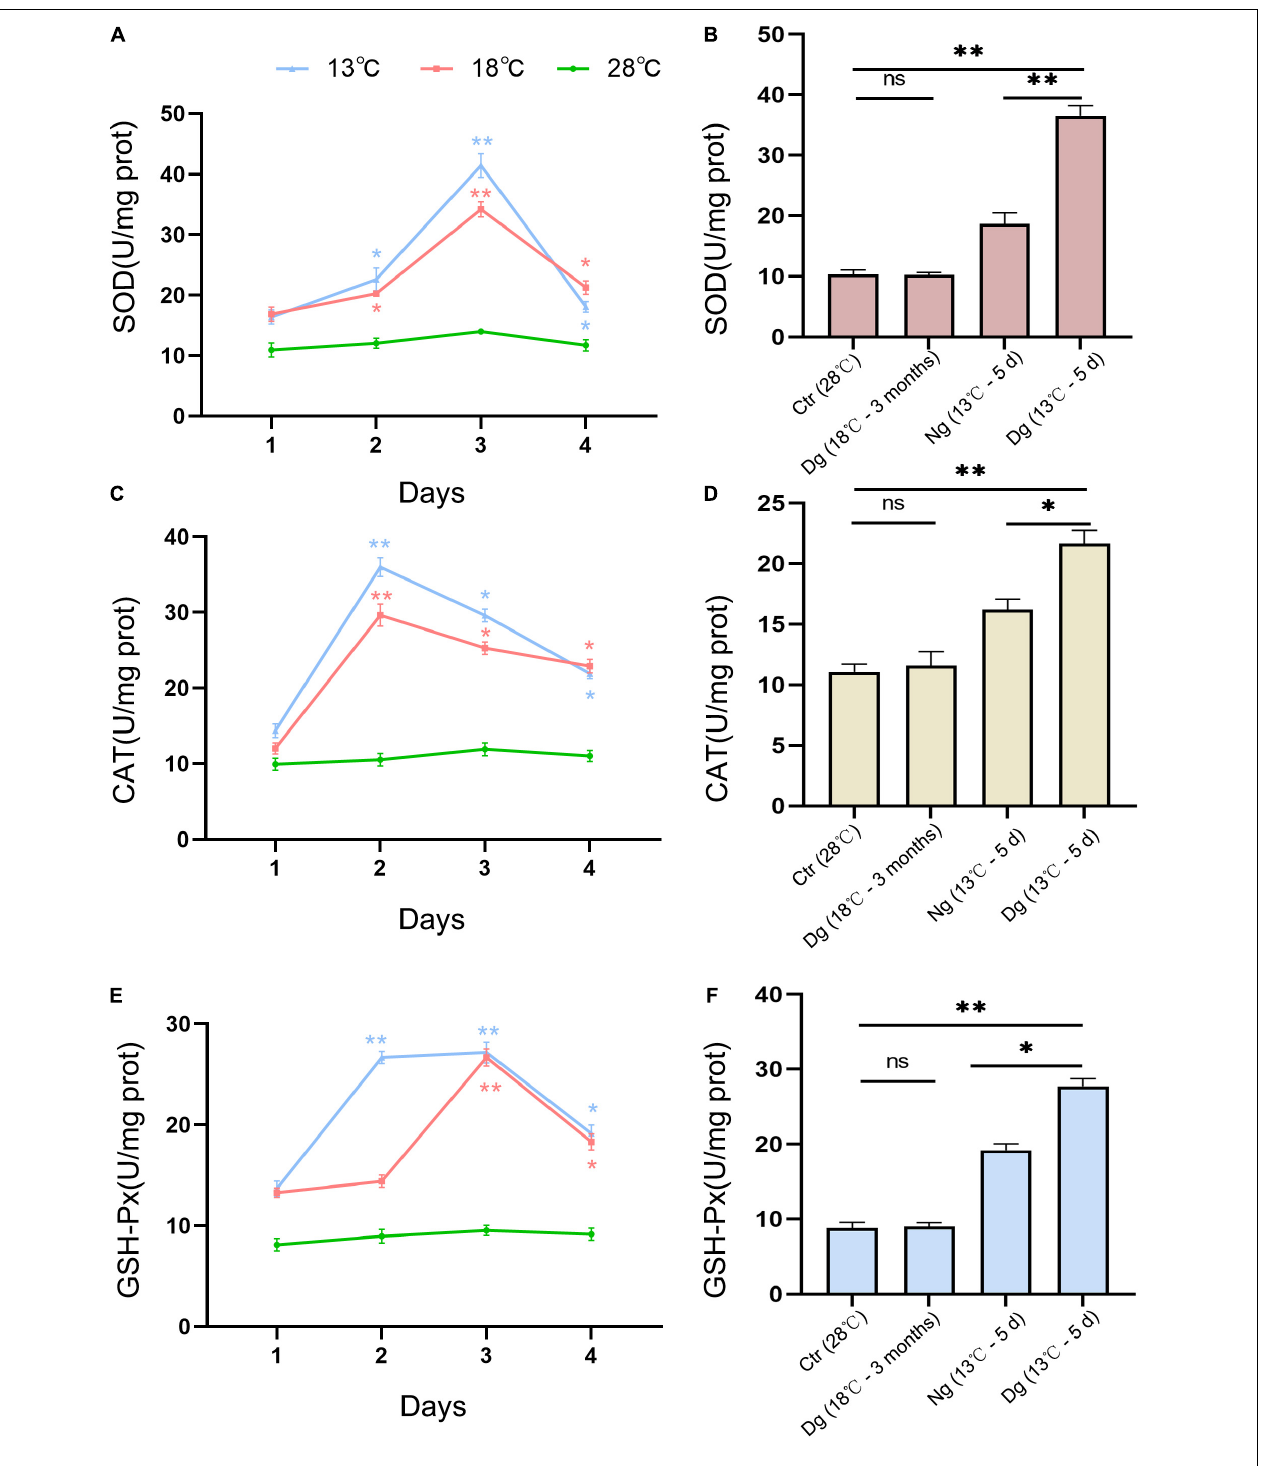
FIGURE 3 | Effects of cold stress on the antioxidant capacity of ZF4 cells. The effects of short-term low temperature stress and long-term cold acclimation on the antioxidant activities of SOD (A,B) , CAT (C,D) , and GSH-Px (E,F) in the ZF4 cells were measured using the corresponding detection kits. Ctr, the control group; Dg, the domesticated group; Ng, the non-domesticated group. The experiments were repeated three times. The results are presented as the mean ± SD ( n = 3); ∗ P < 0.05, ∗∗ P < 0.01.